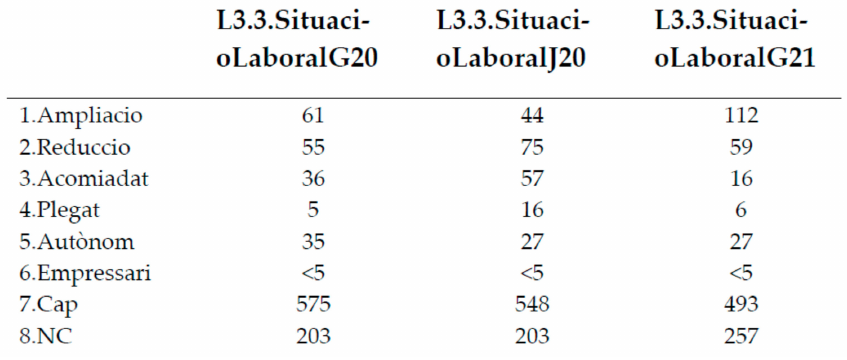
Figure 23. L3.3. Working Situation